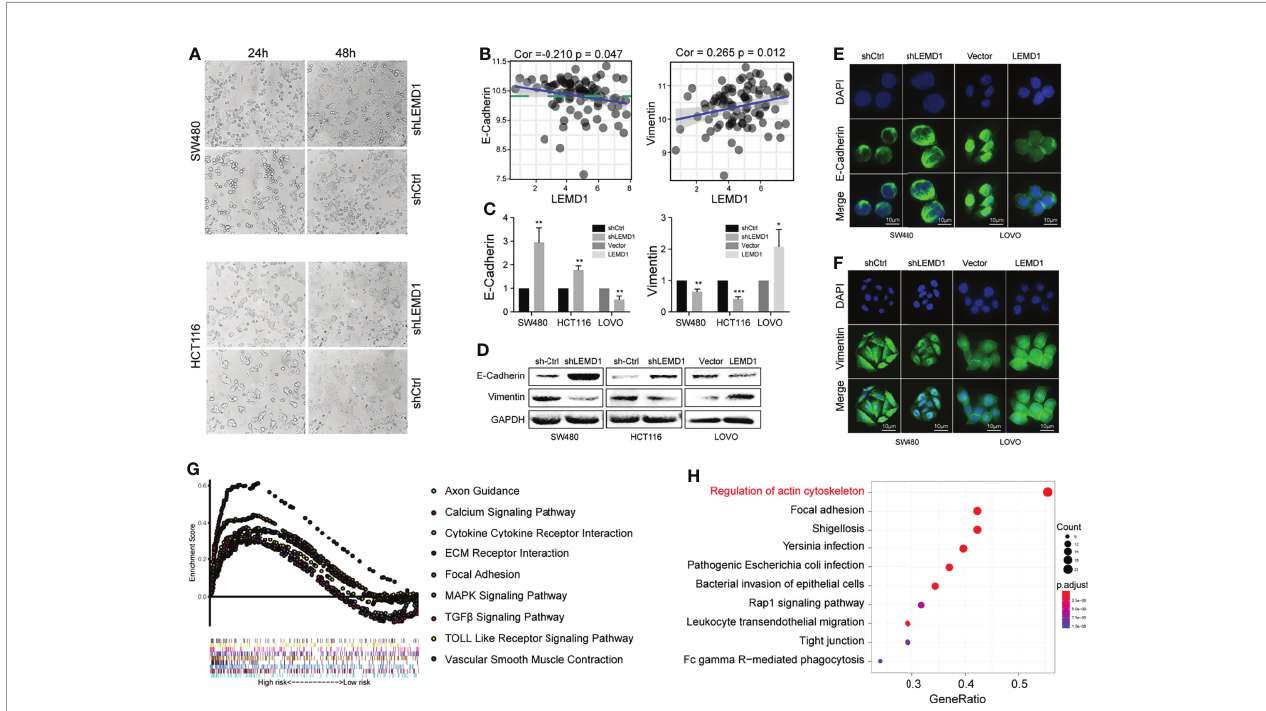
FIGURE 7 | LEMD1 promotes the epithelial-mesenchymal transition. (A) Knockdown of LEMD1 expression changed the morphology of SW480 and HCT116 after 24 and 48 h cultures; (B) Correlation between LEMD1 and EMT biomarkers in GSE33113; (C, D) qRT-PCR (C) and western blotting (D) to detect E-cadherin and vimentin in cells overexpressed with shLEMD1 and LEMD1-overexpressed cells; Immuno fl uorescence to detect E-cadherin (E) and vimentin (F) after LEMD1 knockdown and overexpression in SW480 and LOVO; (G) GSEA enrichment analysis of LEMD1-related pathways in the TCGA database; (H) KEGG enrichment analysis revealed the pathway related to LEMD1. *p < 0.05; **p < 0.01; ***p <